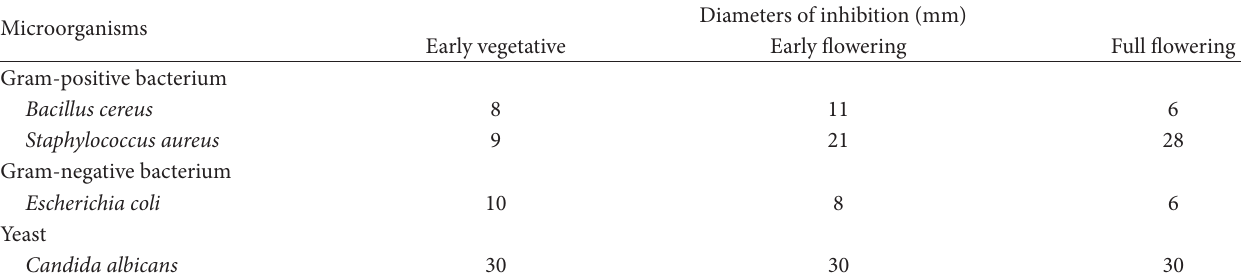
Diameters of inhibition